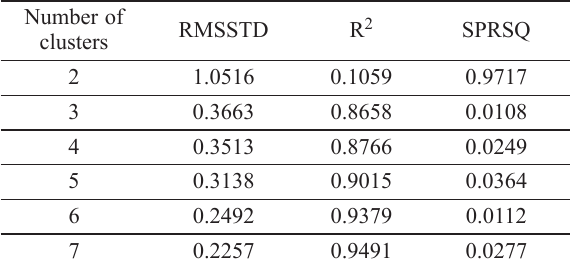
Table 4. Calculated values of RMSSTD, R 2 , and SPRSQ for project A1